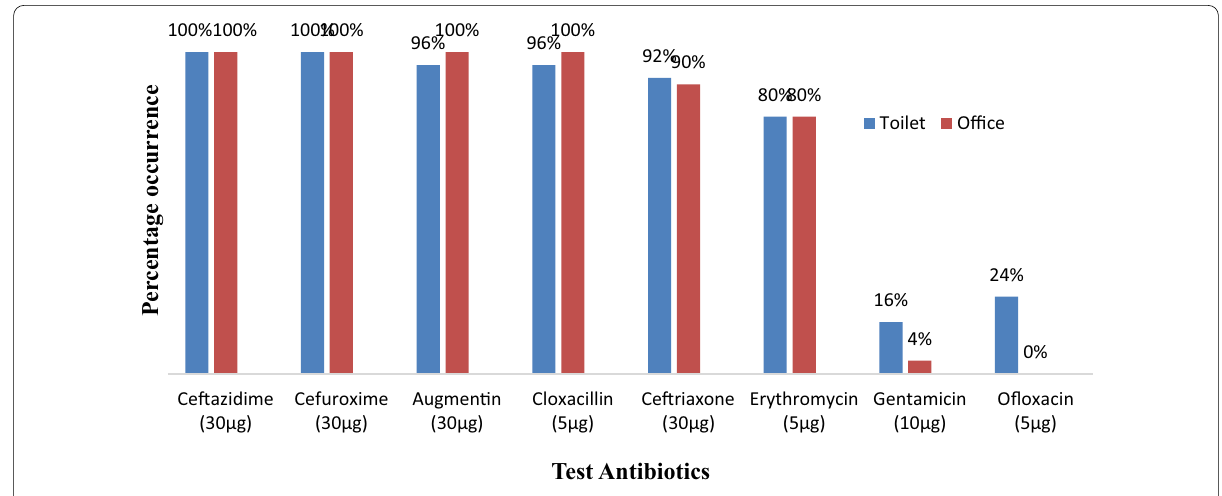
Fig. 3 Effect of source on antibiotic resistance of bacterial